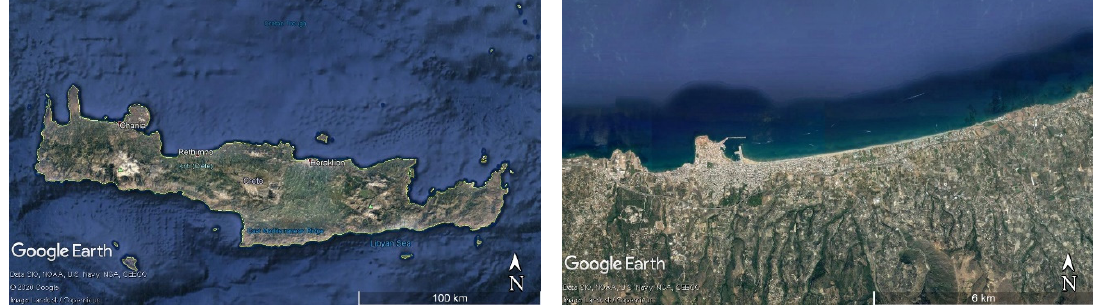
Figure 2. The island of Crete ( left ) and the study area of the coastal zone of Rethymno ( right ) where the MIKE21 Coupled Model FM was implemented. Adapted from [54], with permission from Google Earth, 2020.